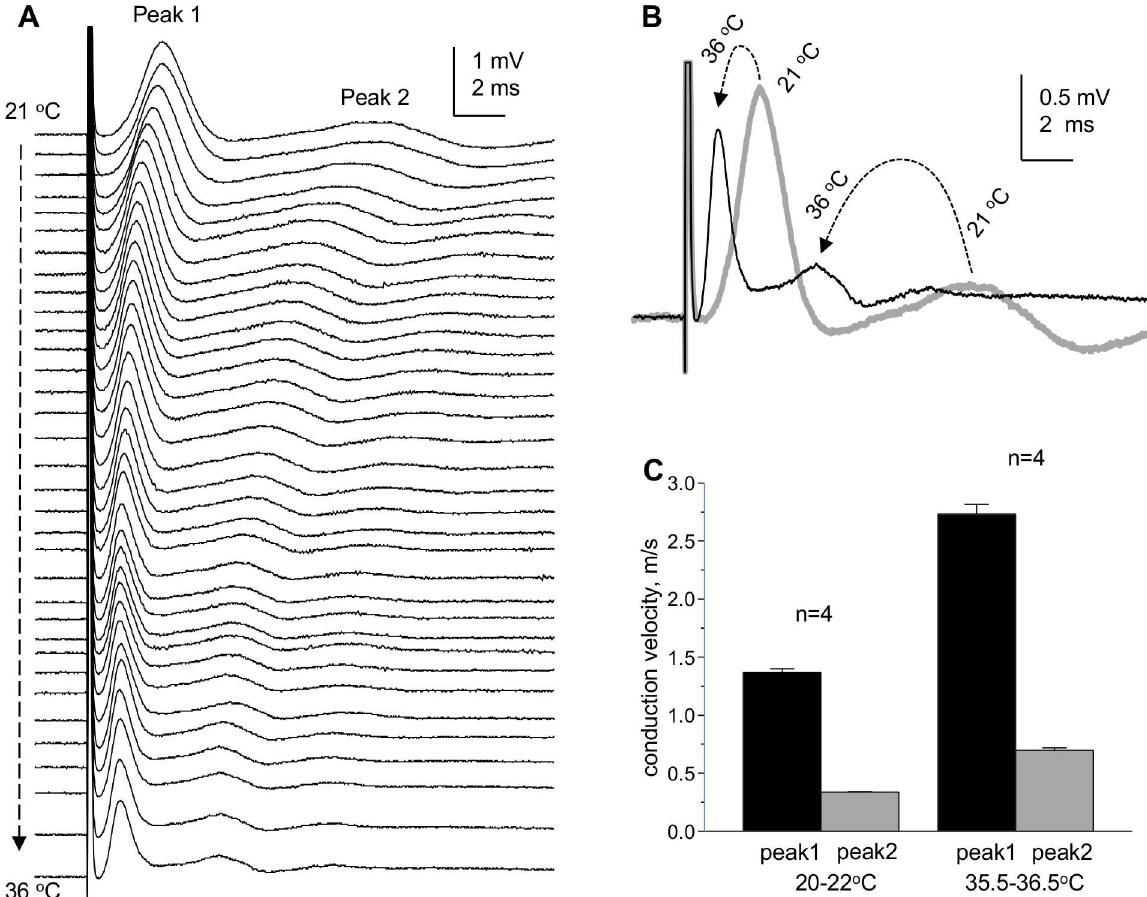
Fig 6. Temperature dependence of “whole” CC CAPs. (A) Superimposed “whole” CC CAPs recorded during the increase of the temperature of perfusingsolutionfrom 21˚C to 36˚C. (B) Superimposed CAPs recorded at 21˚C (thick gray trace) and 36˚C (thin black trace). The dashed arrows show the changesof CAP peaks from room to high temperature. The CAPs shown in this figure were recordedwithout averagingto reflect the changesduringthe temperature test. From these experiments, we estimated the Q 10 of conductionvelocitiesof peak 1 (myelinated axons) and peak 2 (non-myelinated axons) as 1.33 and 1.37,